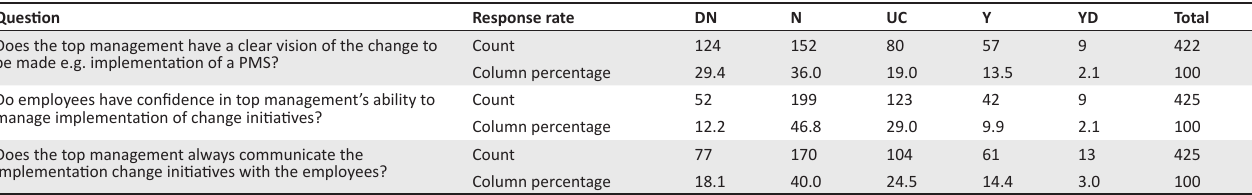
TABLE 5: Clear vision and commitment.